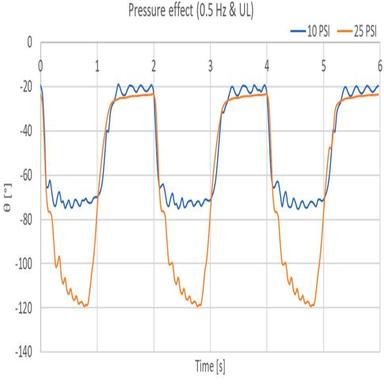
Rotation angle – pressure effect (0.5 Hz & UL).